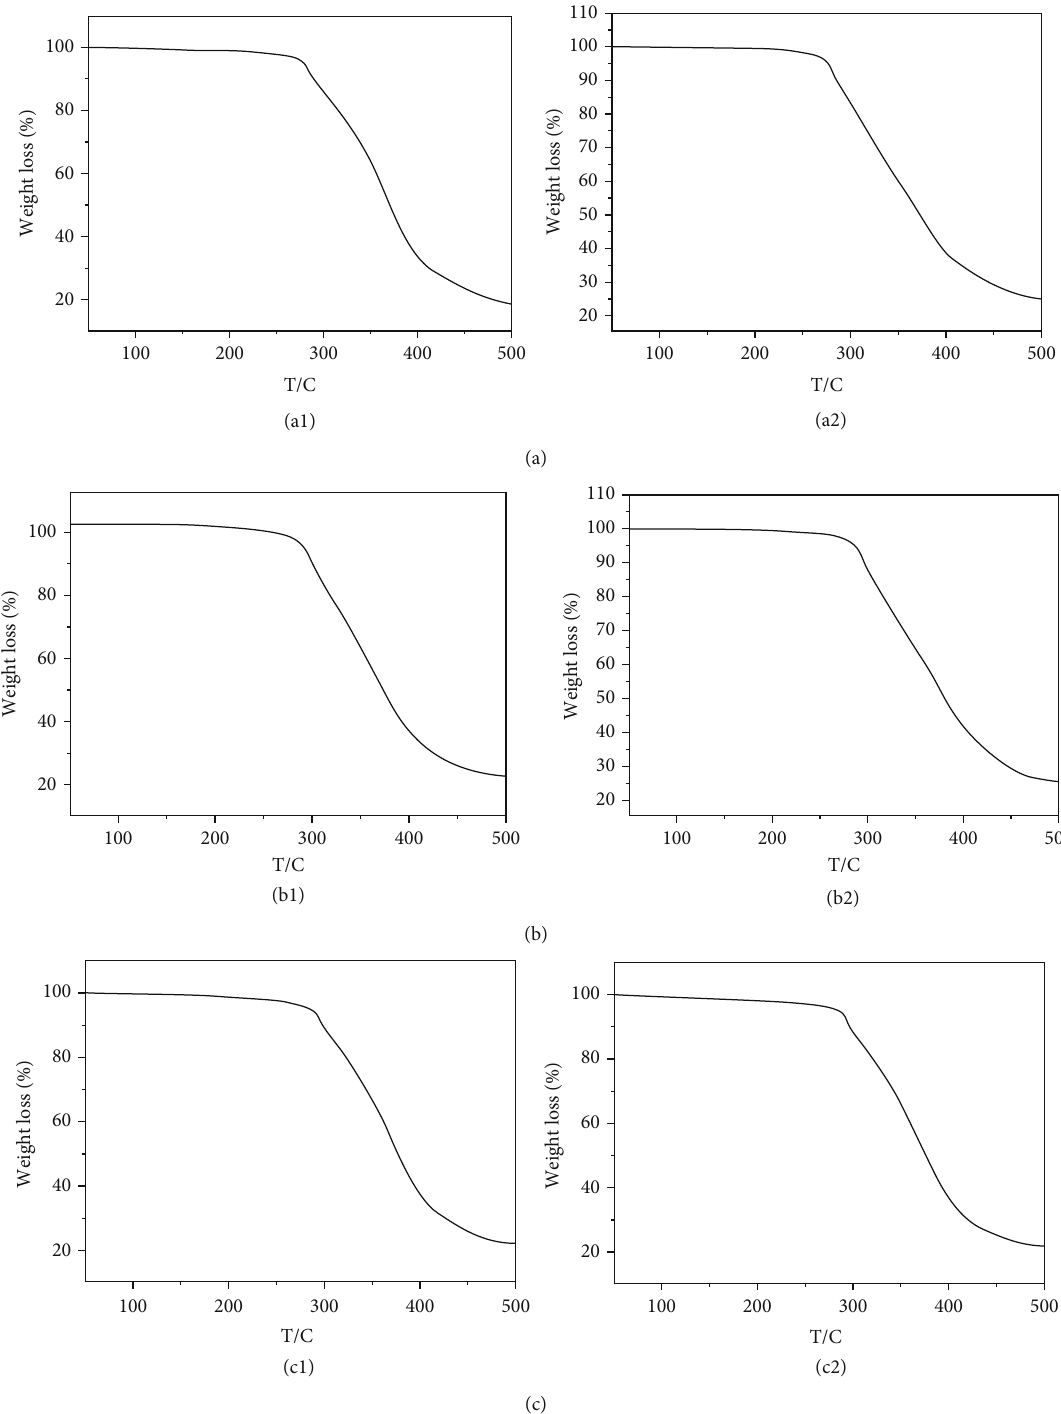
and air atmosphere (1, N 2